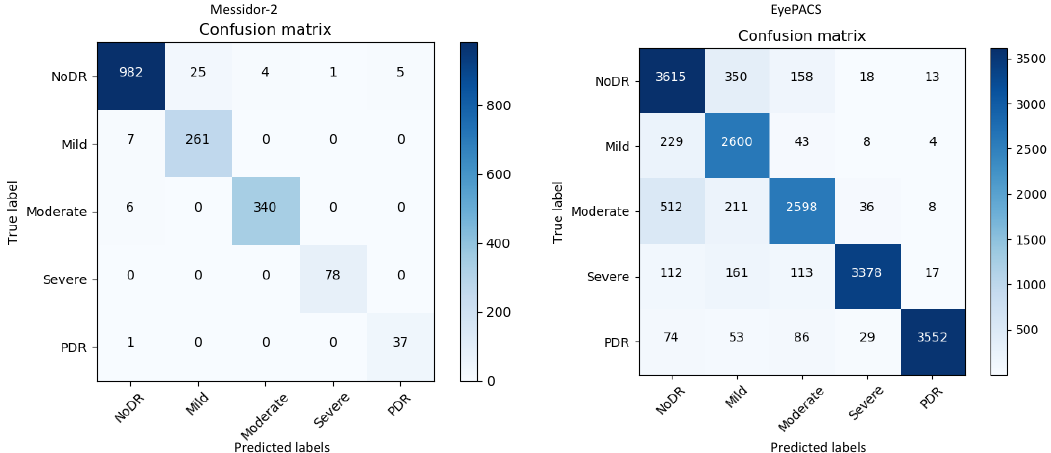
Figure 3. Results of the confusion matrices for both datasets, using a trained deep and densely connected model. Actual and predicted labels are displayed on the y-axis and x-axis, respectively.